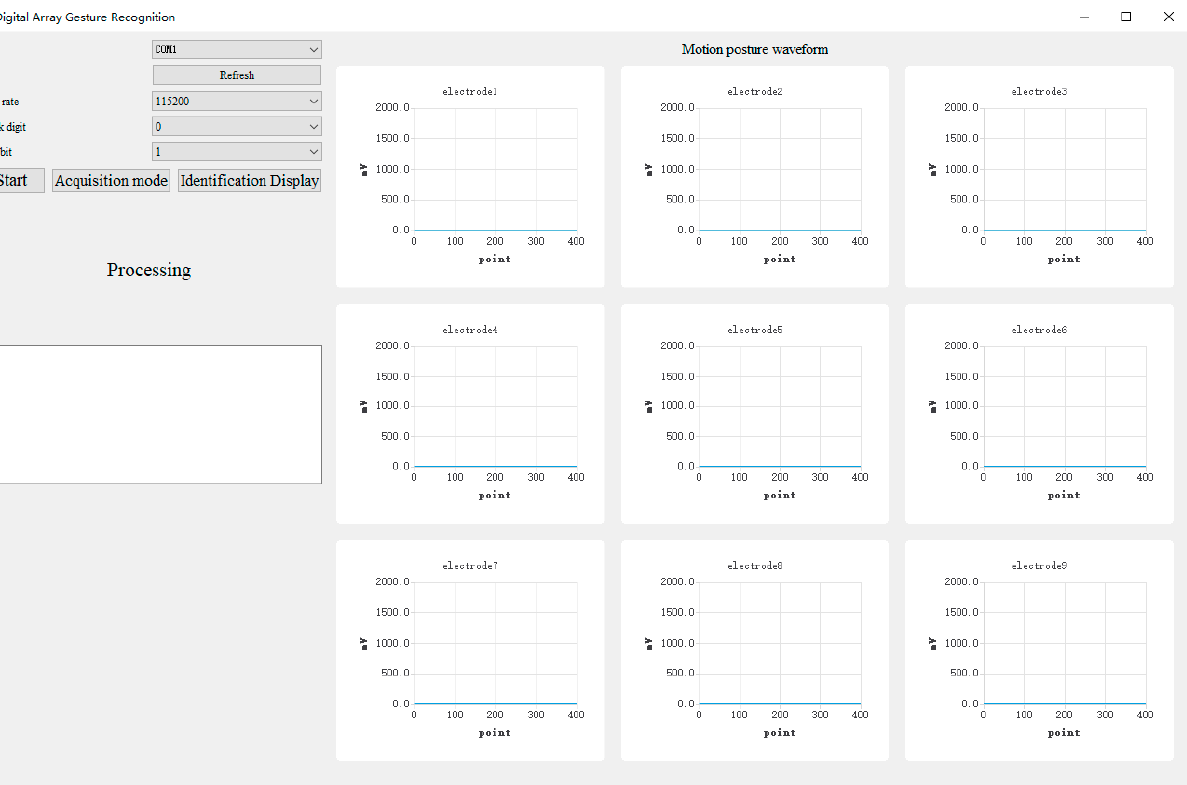
Figure 4. Schematic diagram of front-end circuit.